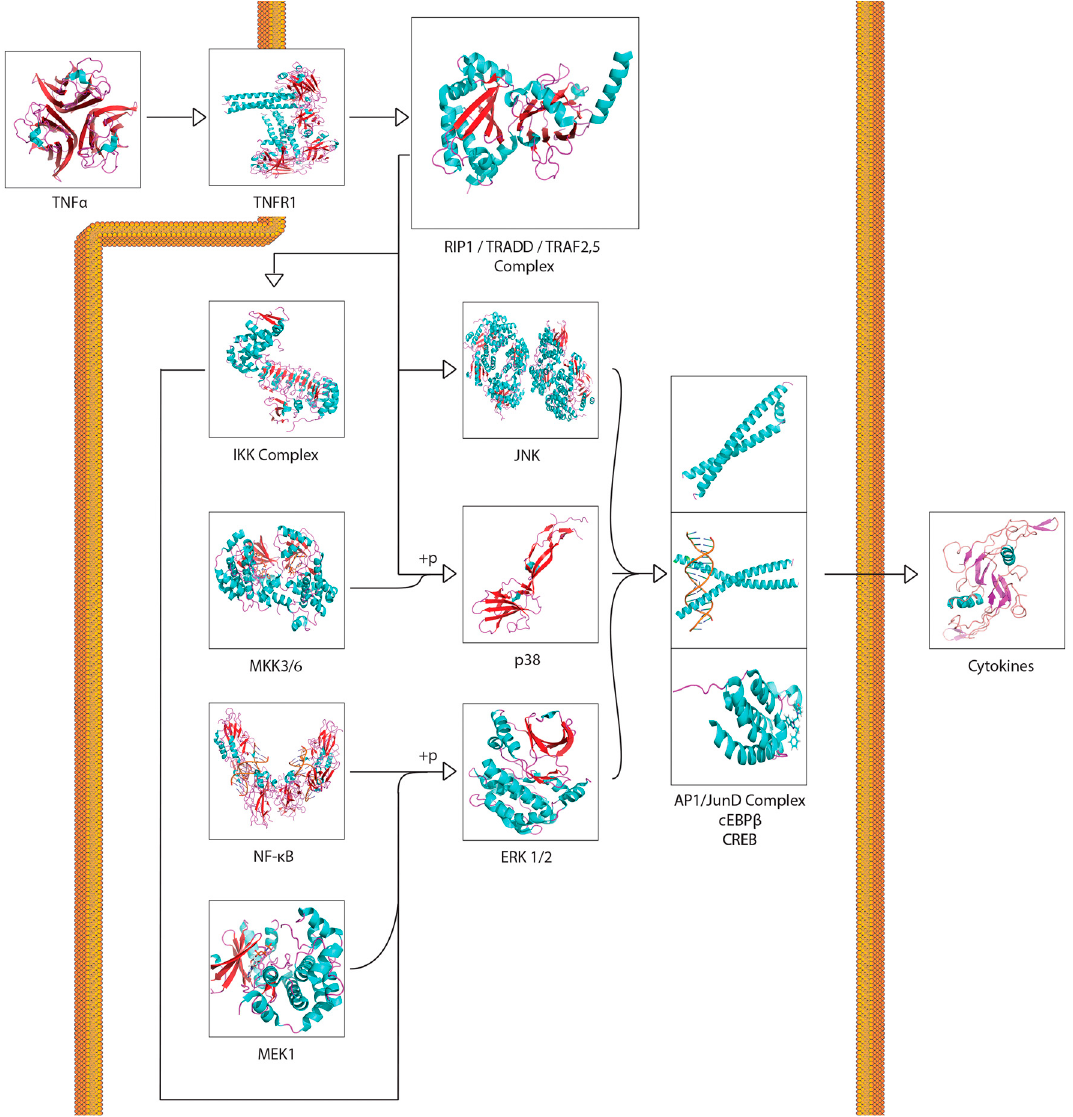
Figure 2. A simplified TNF α signalling transduction pathway. Activation of this pathway could lead to propagation of the RIBE signal through TNF α recognition and subsequent cytokine release.